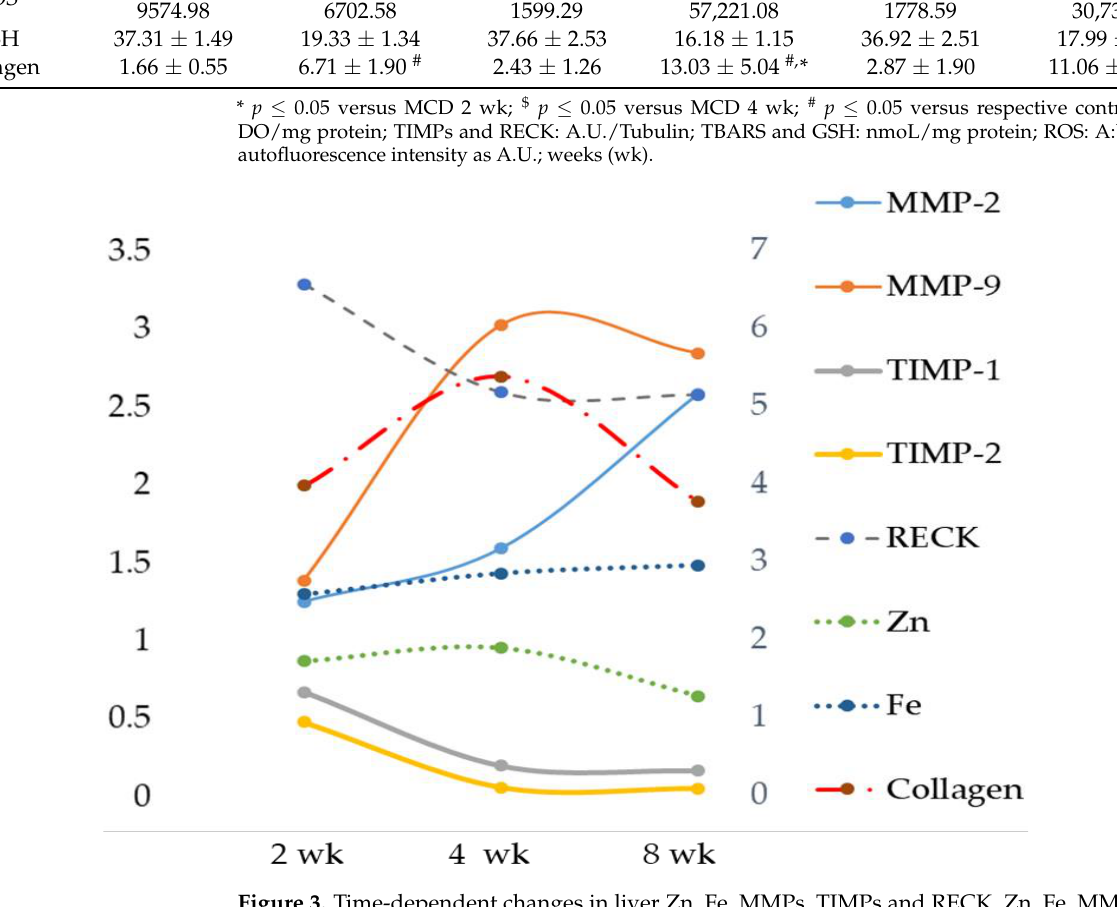
Figure 3. Time-dependent changes in liver Zn, Fe, MMPs, TIMPs and RECK. Zn, Fe, MMPs, TIMPs and RECK are expressed as a fold of increase/decrease in their respective control. Weeks (wk).